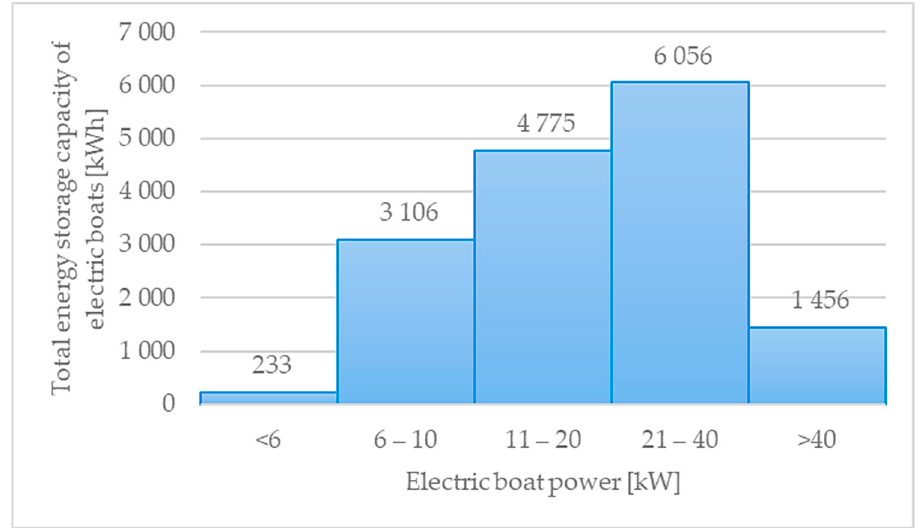
Figure 10. The distribution of the total energy storage capacity of the small electric boats in the sailing marinas of Lake Balaton predicted for 2030 by the power of their electric motors, own results.